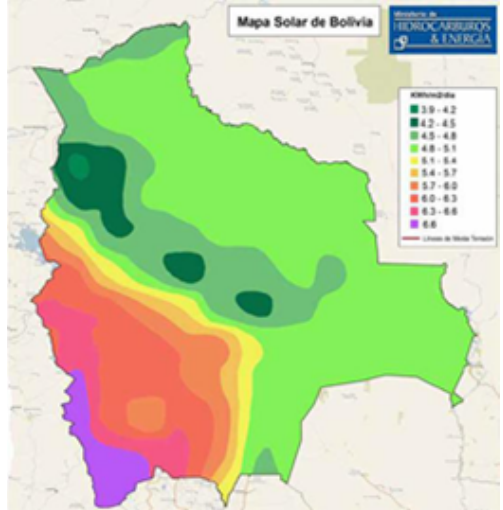
Figure 7. Solar energy potential [53].